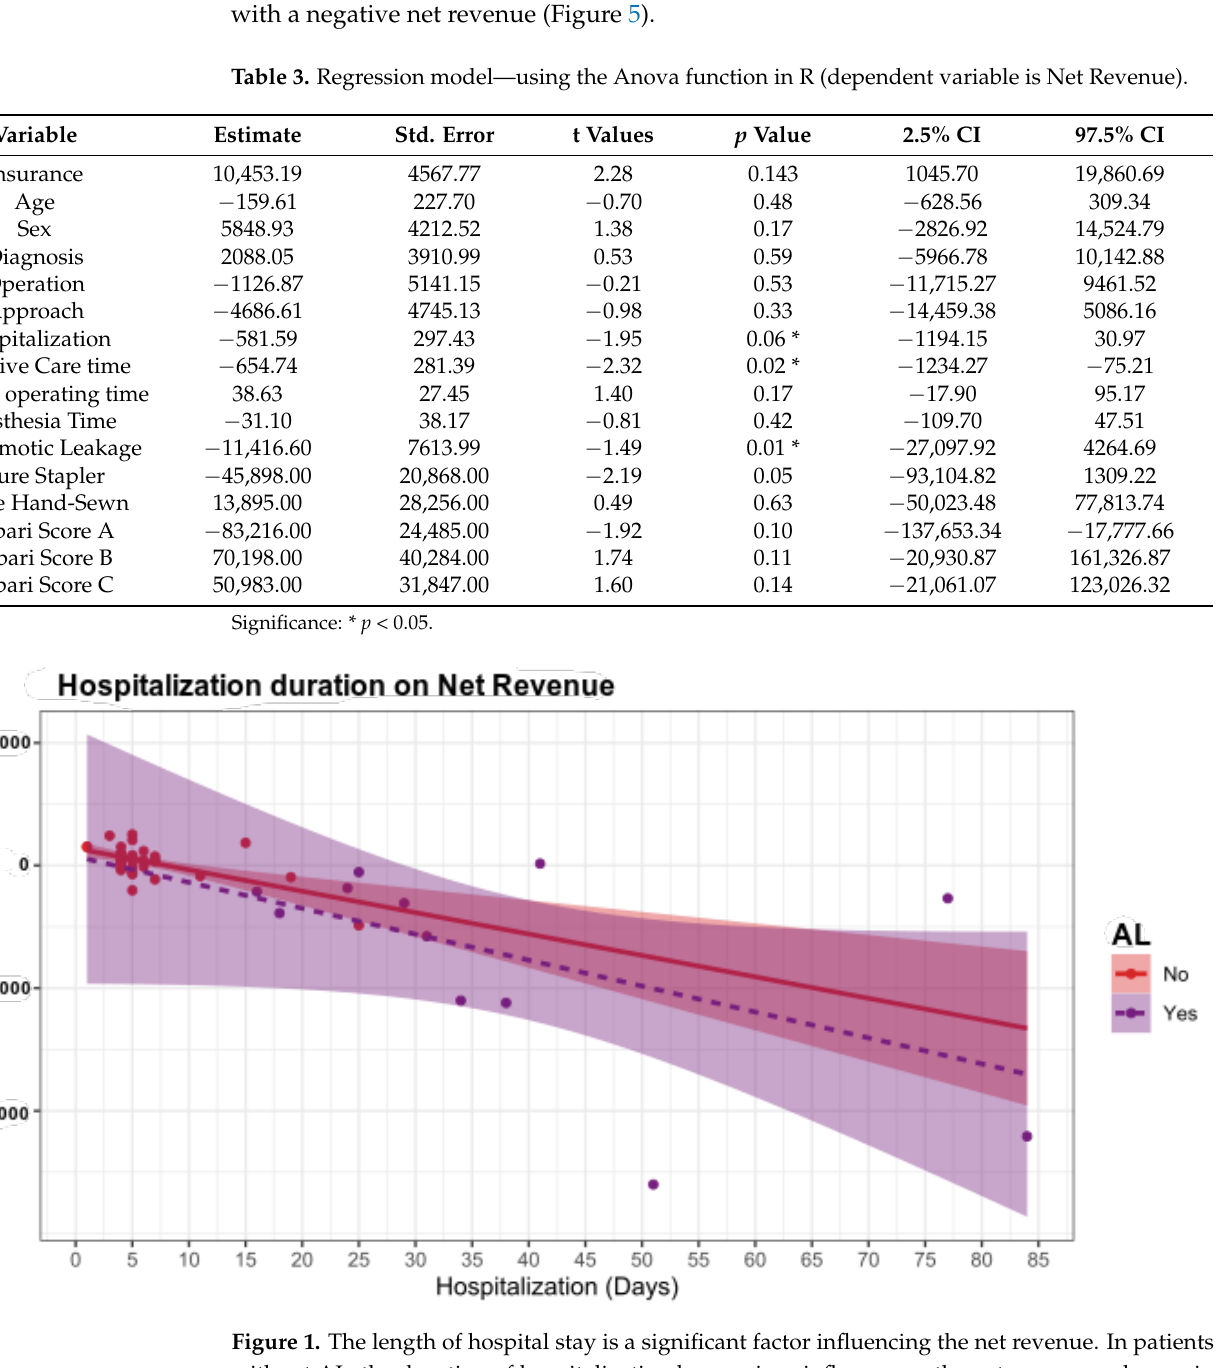
Table 3. Regression model — using the Anova function in R (dependent variable is Net Revenue). Variable